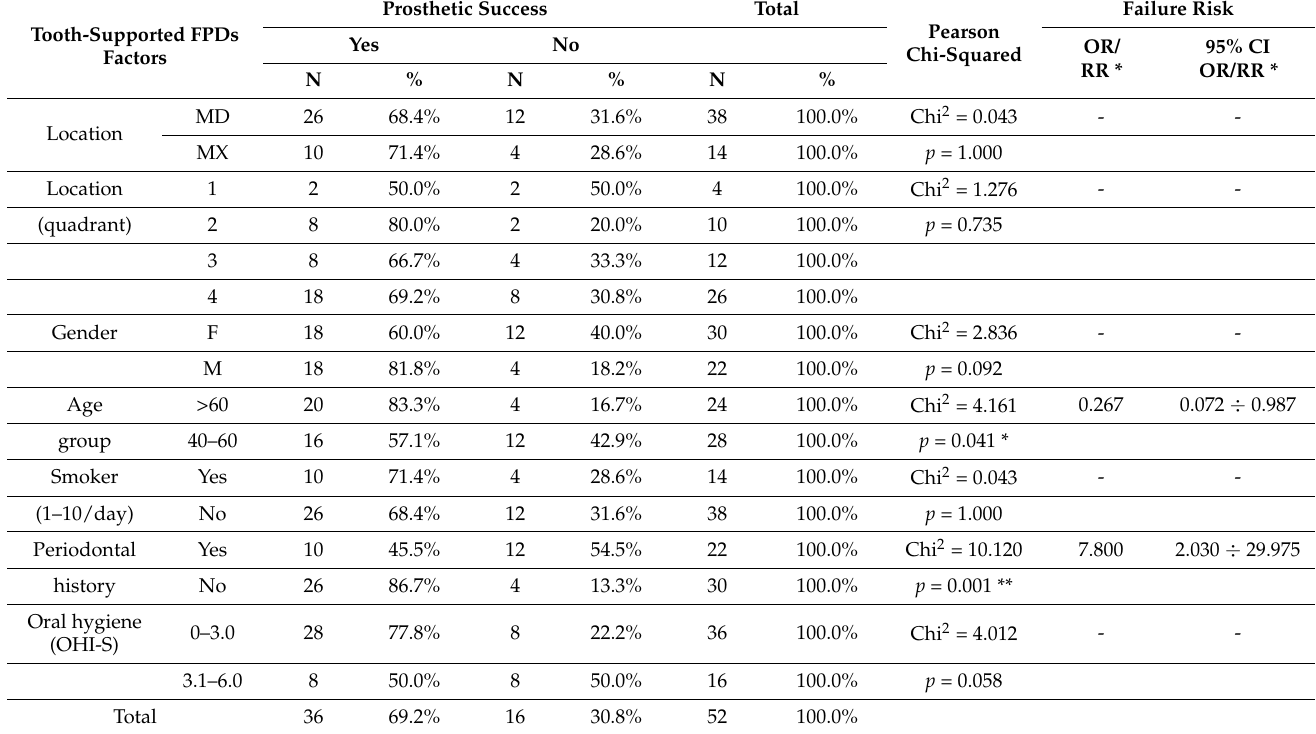
Table 6. Tooth-supported FPDs: failure risk factors.